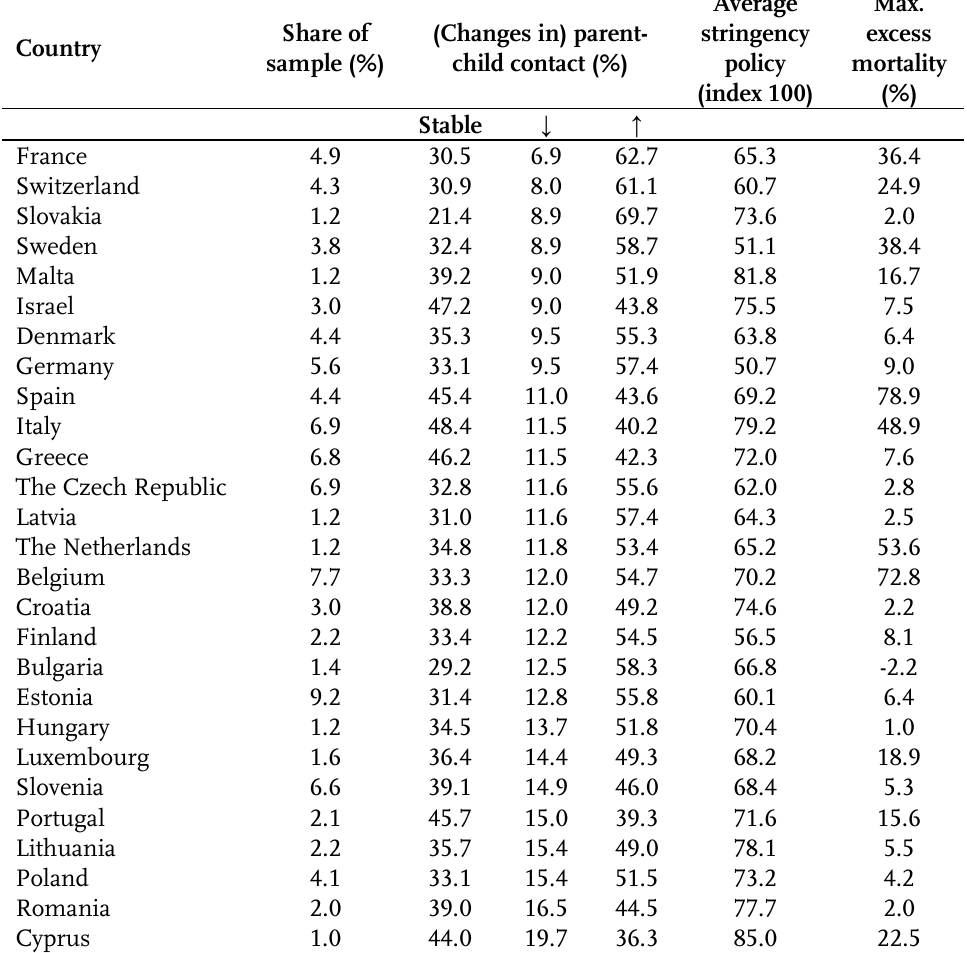
Table 2: Aggregate characteristics of selected countries in the sample Country